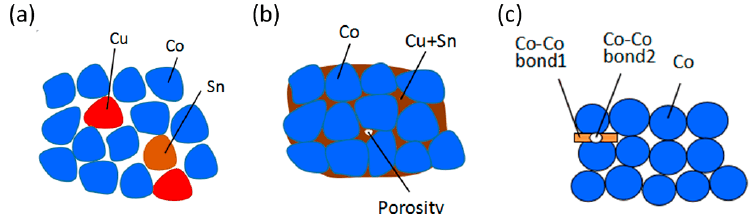
Figure 3. Illustration of Co–Cu–Sn-based metal matrix: ( a ) before sintering, ( b ) after sintering, and ( c ) DEM Co–Cu–Sn metal matrix.